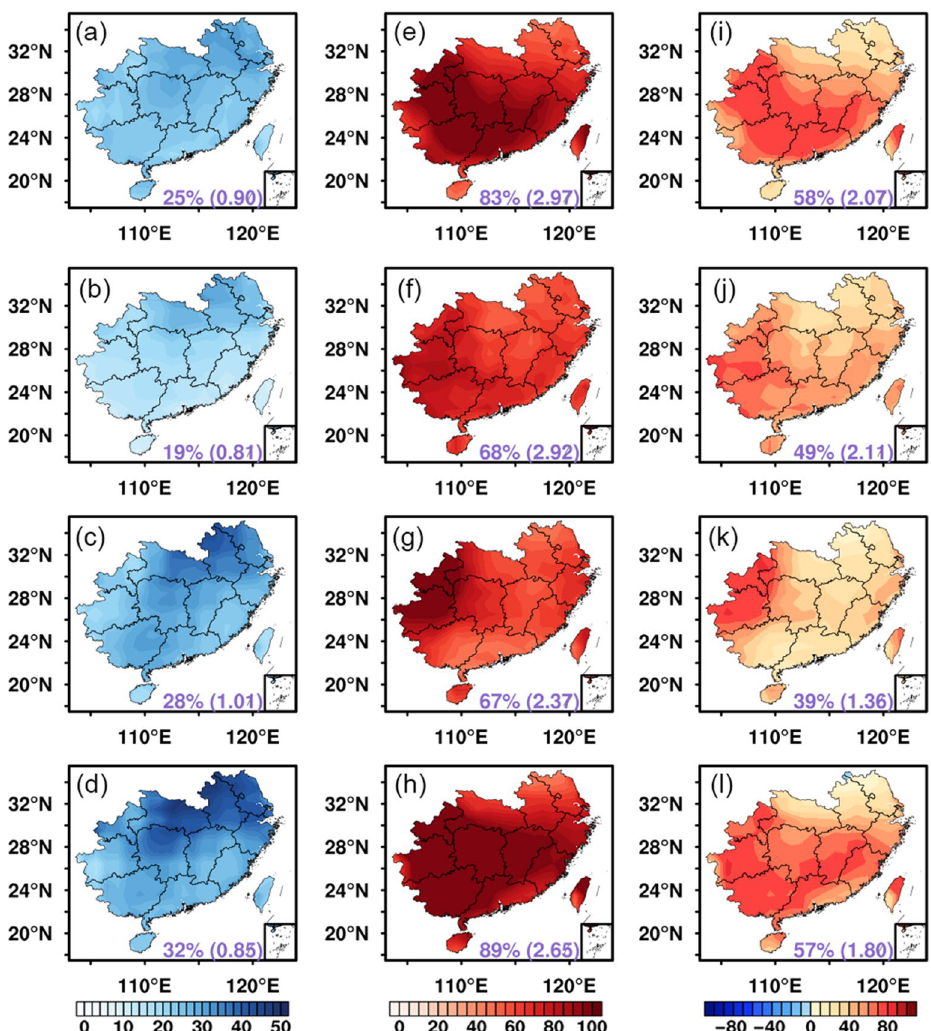
Figure 4. Seasonal averaged impacts of aerosols and clouds on POAI over the SC from 2003 to 2019: ( a – d ) PAE; ( e – h ) PCE; ( i – l ) PCE minus PAE (Unit: %). ( a , e , i ) spring (March–April–May); ( b , f , j ) summer (June– July–August); ( c , g , k ) autumn (September–October–November); ( d , h , l ) winter (December–January–February). The numbers outside the parentheses represent the regional averaged PAE or PCE, while the numbers inside the parentheses represent the regional averages of AE or CE in the unit of kWh/m 2 /d. The map was generated by ESRI ArcGIS 10.5 software available at the ESRI website (https:// www. esri. com/ en- us/ arcgis/ produ cts/ arcgis- platf orm/ overv iew). The administrative boundary shapefile for southern China is available at the RESDC website (https:// www. resdc.